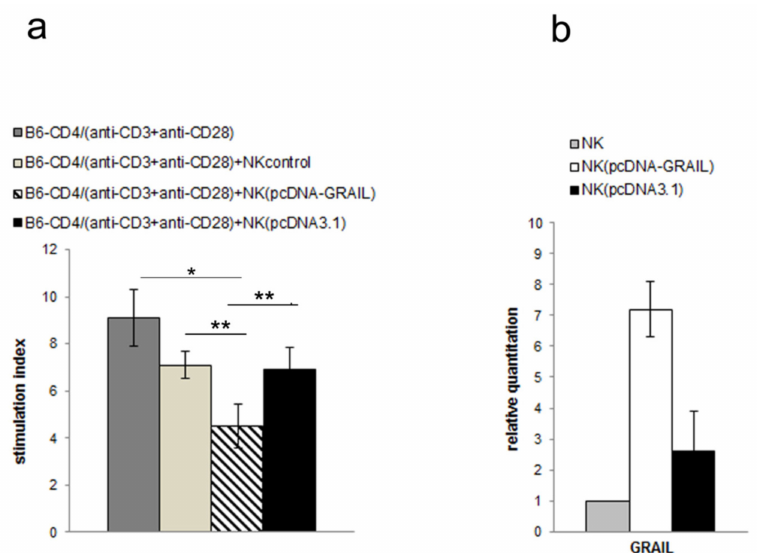
Figure 4. ( a ) The proliferation of anti-CD3 and anti-CD28 stimulated CD4 + T cells isolated from naïve C57BL6 / J mice cocultured with NK cells isolated from naïve C57BL6 / J mice non-transfected or transfected with pcDNA-GRAIL or pcDNA3.1 was assessed by [3H] thymidine uptake. Stimulation indices are shown as mean ± SD obtained from three independent experiments with three to six mice per experiment. * p < 0.001, ** p < 0.05; ( b ) Expression of mRNA GRAIL in NK cells isolated from C57BL6 / J mice non-transfected or transfected with pcDNA-GRAIL or pcDNA3.1 was assessed by qRT-PCR. Ratio of mRNA was calculated versus the level of mRNA in NK cells isolated from naïve C57BL6 / J mice. Data are pooled from three independent experiments with three to six mice per